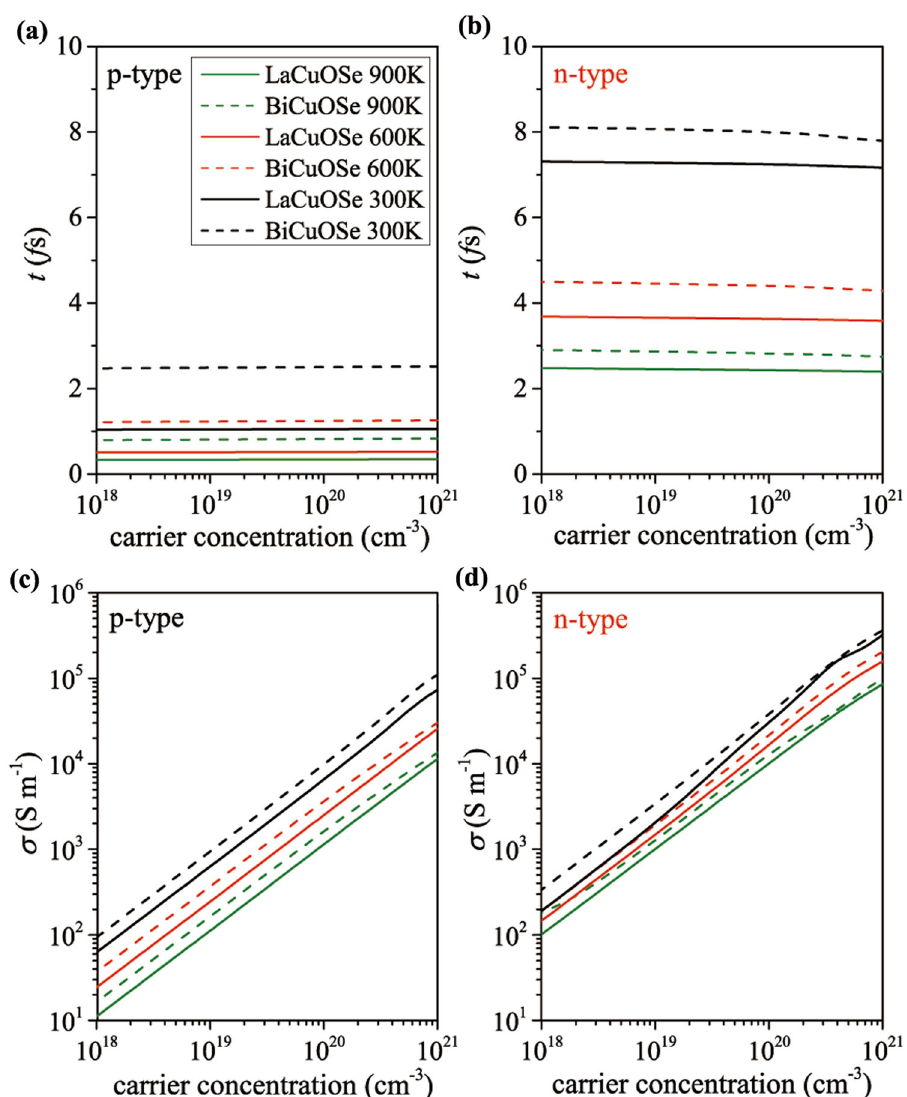
Fig. 3 Relaxation time and electrical conductivity. The relaxation times ( a , b ) and electrical conductivities ( c , d ) for BiCuOSe and LaCuOSe as a function of carrier